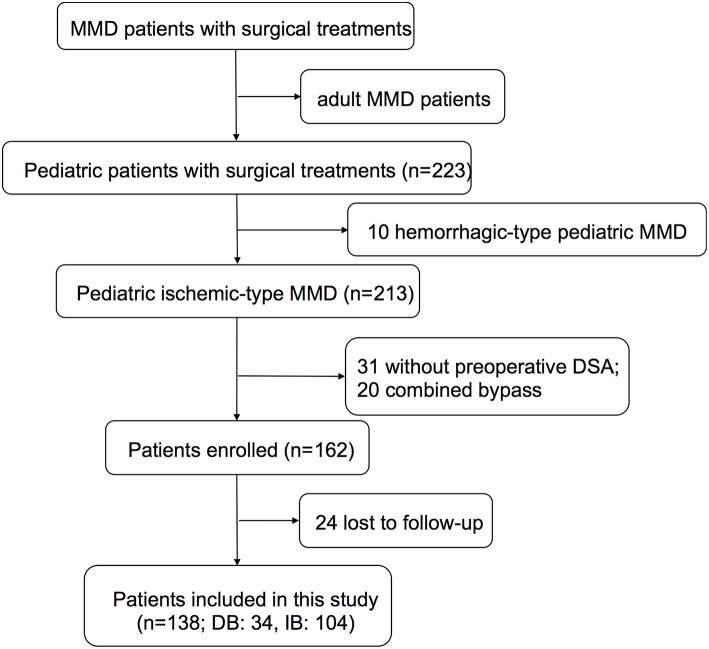
Flow diagram showing the selection of patients in the study.